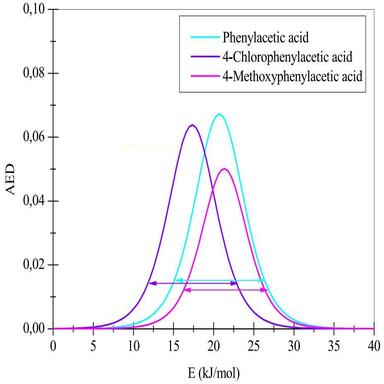
Adsorption energy distributions (AEDs) of the Zebrafish ORA1 activated by phenylacetic acid, 4-chlorophenylacetic acid, and 4-methoxyphenylacetic acid.